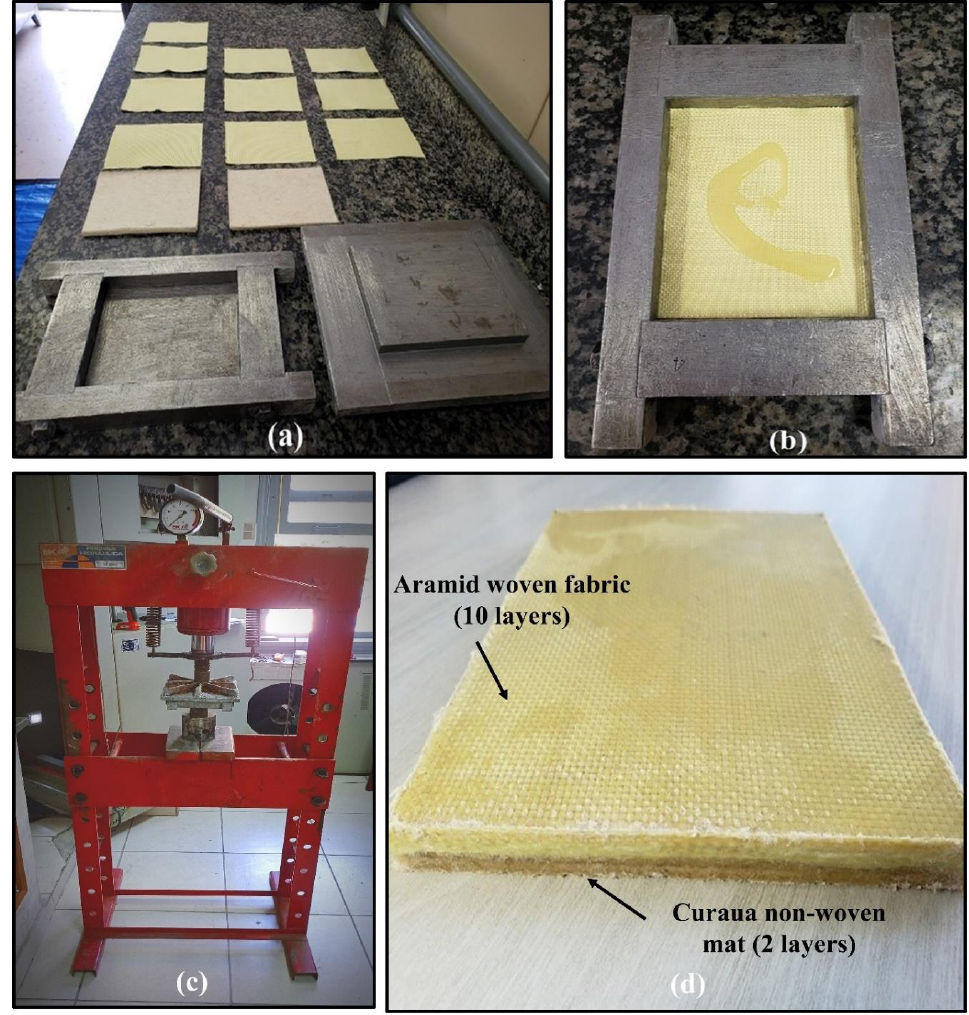
Figure 3. E-10A/2C composite production process: ( a ) aramid woven fabric, curaua non-woven material, and metallic mold besmeared with a release agent ready for cold molding; ( b ) epoxy over aramid woven fabric during processing; ( c ) cold compression molding, and ( d ) fabricated E-10A/2C composite